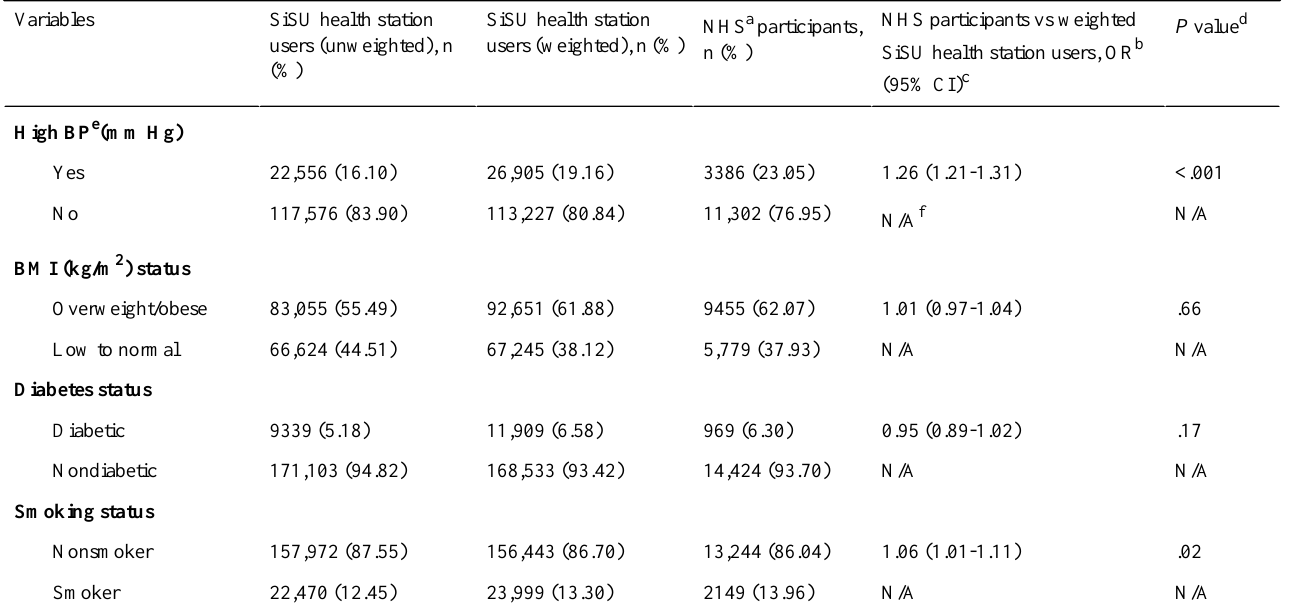
Table 2. Comparison of the health characteristics of SiSU health station users and National Health Survey participants.